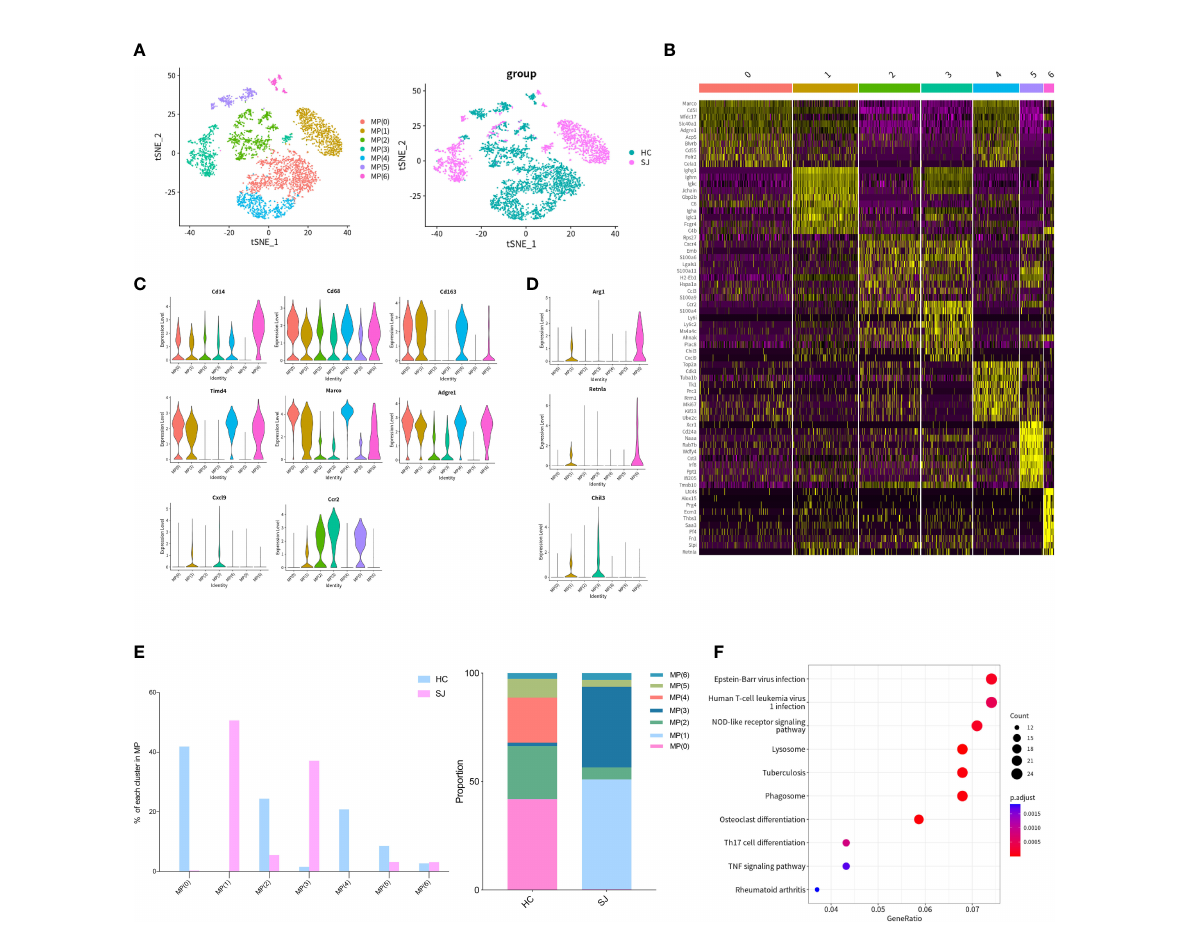
FIGURE 3 M2-like polarization of macrophages in fi brotic liver of schistosomiasis japonica. (A) tSNE plots of the 4,846 monocyte for seven clusters and two groups. (B) Heatmap of MPs for the top 10 DEGs of each cluster. (C) Violin plots of genes in each MPs cluster. (D) Violin plots of M2 maker genes. (E) The percentage change tendency and contribution of each MPs cluster in two groups. (F) Bubble plots of KEGG pathway enrichment DEGs between MP(1) and other MP